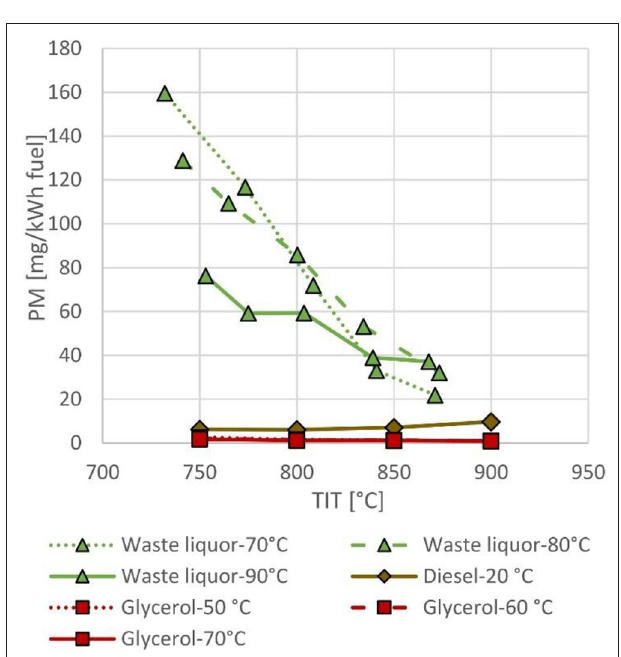
FIGURE 13 | Particulate matter emissions for different fuels at different fuel